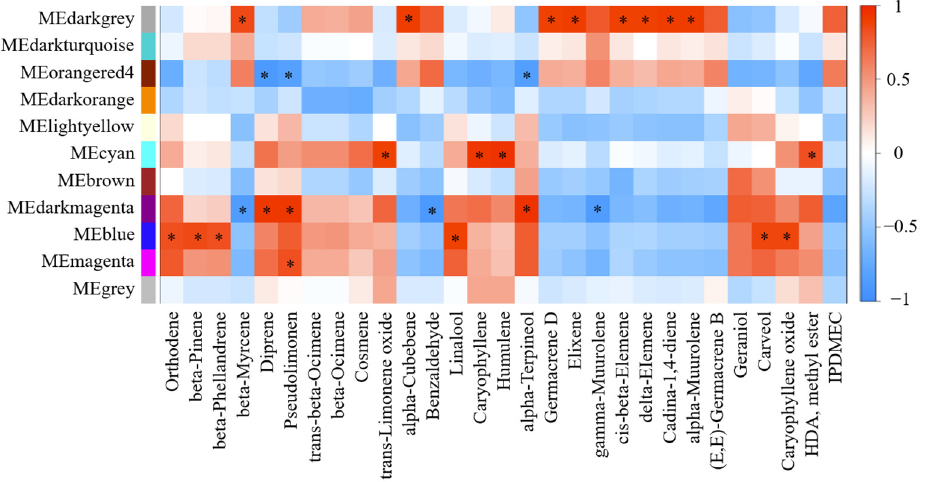
Figure 5. Gene-traits correlation heatmap of WGCNA results. HDA: Hexadecanoic acid; IPDMEC: